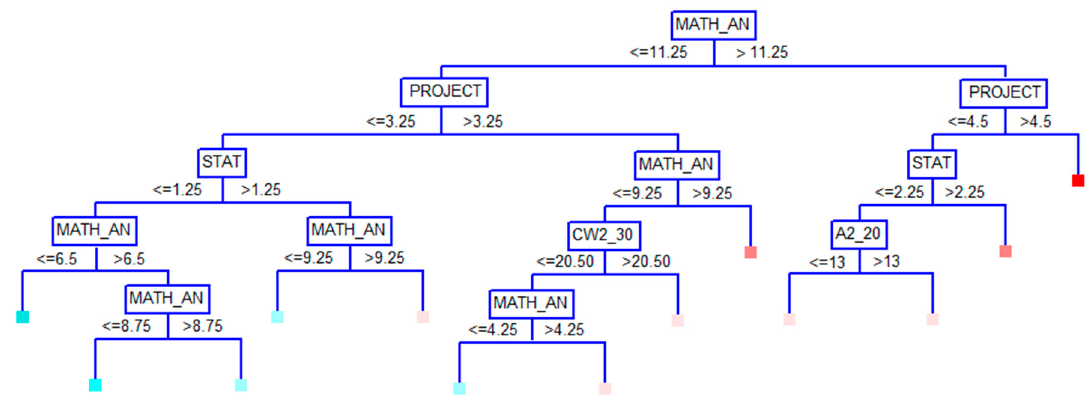
Figure 4. Diagram of the regression tree of CART model M 1 with split variables denoted and respective threshold values for each tree node.